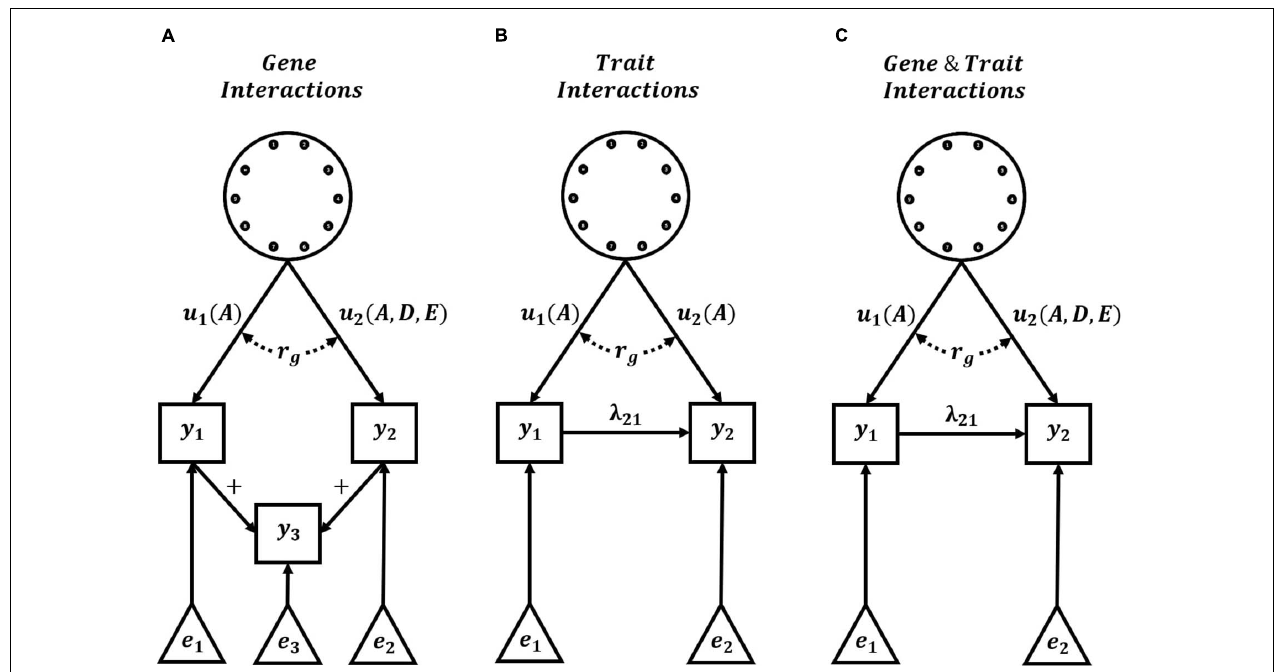
FIGURE 3 | Hierarchical G2P Maps for Plant Breeding. Examples of three multi-trait hierarchical G2P maps with the explicit specification of interactions. Hierarchical G2P maps incorporating knowledge of trait interactions ( + , λ ) can be used to adjust phenotypes and increase the accuracy of the estimation of gene effects ( u ), gene interactions, and genetic correlations ( r g ) between traits. Gene effects ( u ) can be directly assigned to trait phenotypes ( y ) or indirectly assigned via linear trait relationships (+) or non-linear trait interactions ( λ ) . A, D, and E indicate additive, dominance, and epistatic functional genetic effects, respectively. Non-genetic effects of trait phenotypes are represented by e . (A) Representation of a G2P map with gene interactions and linear relationship between trait phenotypes, (B) Representation of current Crop Growth Model – Whole Genome Prediction (CGM -WGP) G2P maps with additive genetic effects and non-linear trait interactions, and (C) Representation of potential G2P maps with both gene interactions and non-linear trait interactions.